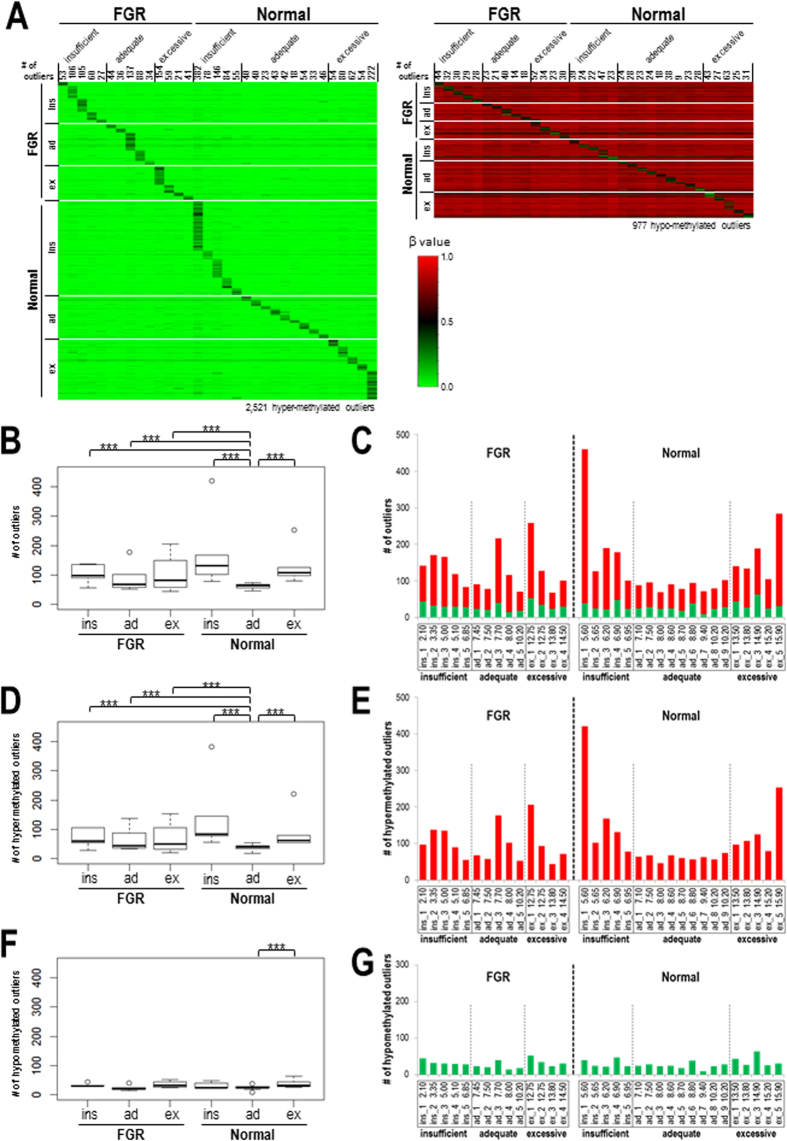
(A) Heatmap visualisation of the β value of methylation outliers detected by Smirnov-Grubbs’ outlier tests. The numbers of outliers detected in each placenta are indicated above the heatmap. The colour scale represents the β value from 0 to 1. The left and right panels represent hypermethylated and hypomethylated outliers, respectively (B,D,F). Box plots showing the distribution of the numbers of outliers in each of six placental categories (***, Tukey’s multiple comparison test P-value < 0.001). ins, insufficient; ad, adequate; ex, excessive (C,E,F). Bar plots for the numbers of outliers in FGR and normal subjects sorted according to weight gained during pregnancy. Plots for all outliers (B,C), hypermethylated outliers only (D,E), and hypomethylated outliers only (F,G) are shown. Red and green bars represent the numbers of hyper- and hypomethylated outliers, respectively (C,E,F).